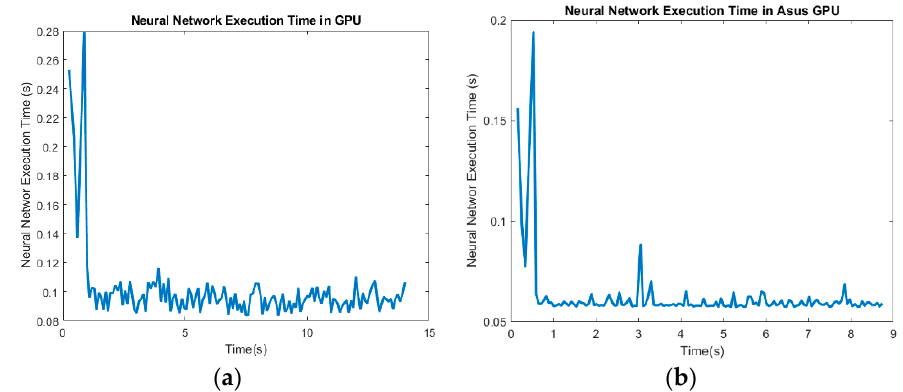
Figure 17. Neural Network execution time: ( a ) on a Quadro P1000 GPU and ( b ) on an Asus GeForce